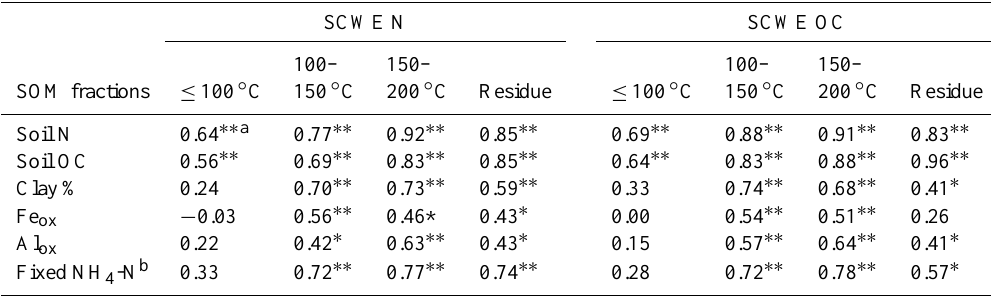
Table 3. Pearson’s correlation coefficients ( n = 25) between subcritical water extracted N and C (gkg − 1 ), contents of soil N, soil OC, ammonium oxalate extractable Fe and Al (Fe ox , Al ox ), and fixed NH 4 -N (gkg − 1 ) and the soil clay percentage (clay%). SCWE N SCWE OC